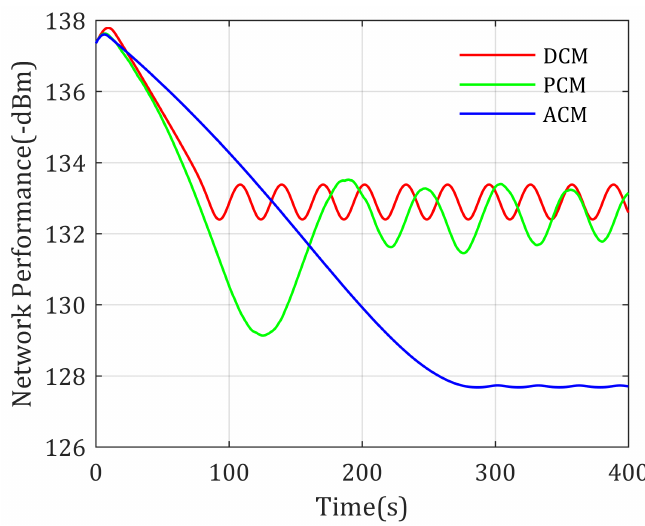
Figure 9. Network performance for multi-static-agents-inter communication with known channel parameters.